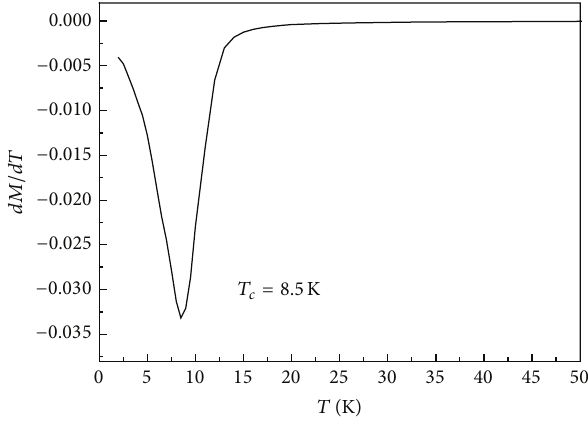
and the Curie-Weiss temperature (𝜃) are estimated by a linear fitting of 1/𝜒 = (𝑇 − 𝜃)/𝐶 at the linear region [8–10]. Fitting yielded that the Curie constant 𝐶 = 15.20 cm paramagnetic Curie temperature 𝜃 = −9.32 K. The values of 𝜃 , and 𝐶 are different from those values for ferrimagnet 𝑇 𝐶 , Ni 1.5 [Fe(CN) 6 ] ⋅ x H 2 O [10] and Mn 3 [Fe (CN) 6 ] 2 ⋅ 15H 2 O ( 𝑇 𝐶 = 9 K)